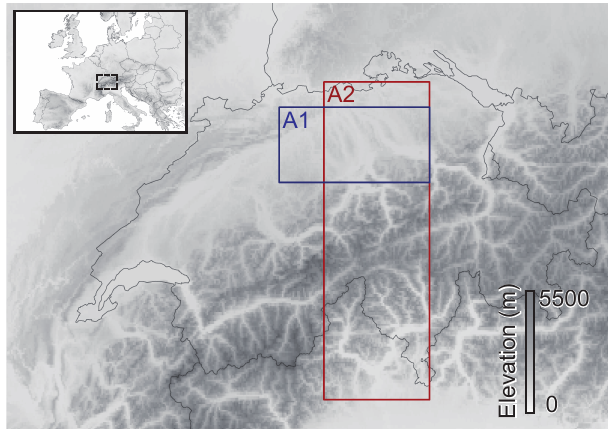
Figure 4. Location of the two simulation areas in Switzerland and in Europe. The map illustrates the differences in elevational hetero- geneity (digital elevation model by Jarvis et al., 2008) between the simulation area of scenario A1 and of scenario